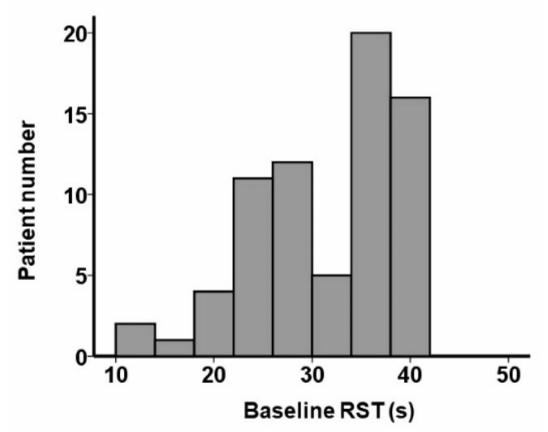
Figure 2. Distribution of baseline